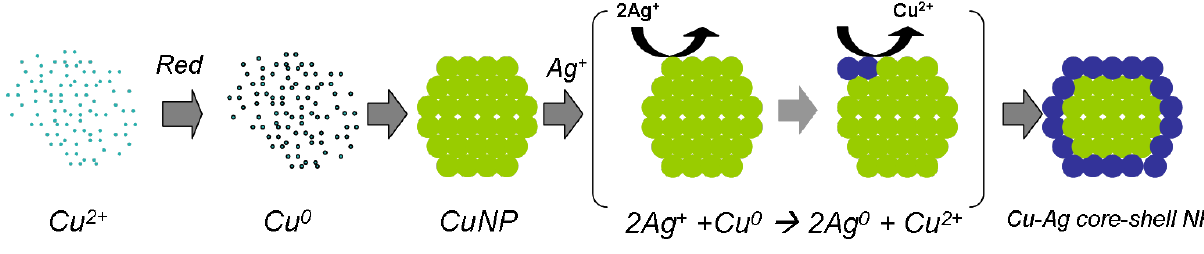
Figure 4. Schematic illustration of a single Cu NP synthesis and the formation of a silver shell by the transmetalation reaction. The surface copper atoms serve as reducing agents for the silver